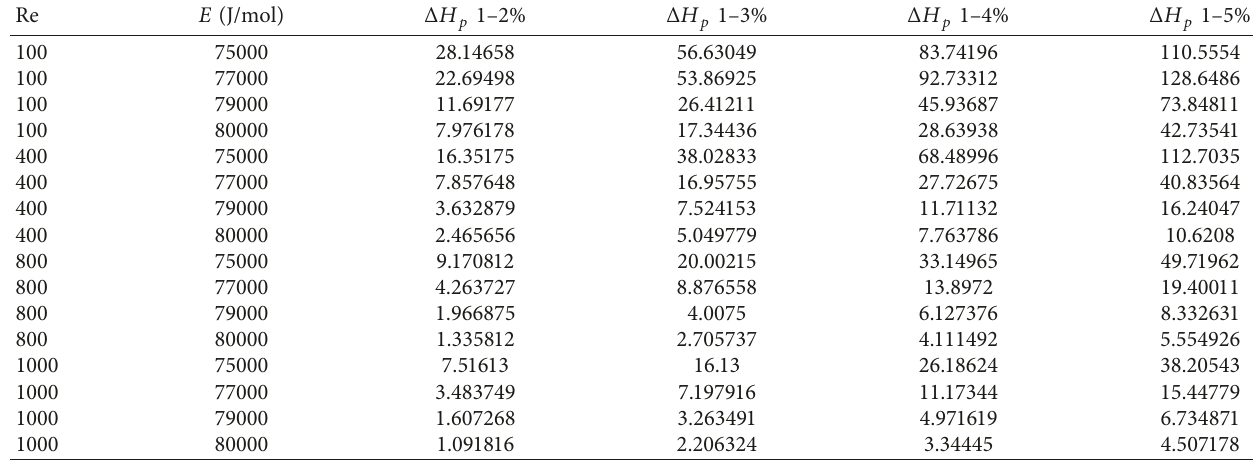
Figure 11: Enthalpy change of the system: (a) I.C � 5%, E � 80,000J/mol; (b) I.C � 5%, Re � 1000; (c) Re � 1000, E � 80,000J/mol. Table 4: Percentage change in the maximum enthalpy of initial concentration from 1% to